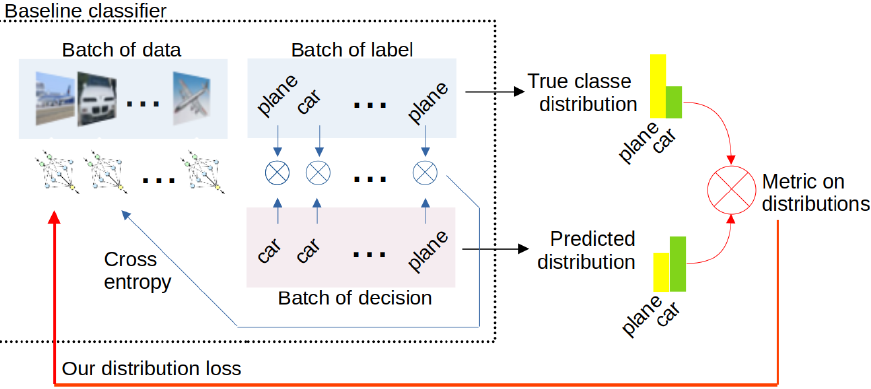
Figure 1. Overview of our approach for class-based sub-populations: our contributions are the consideration of the problem of class distribution estimation and the successful back-propagation of a metric on distributions into the baseline